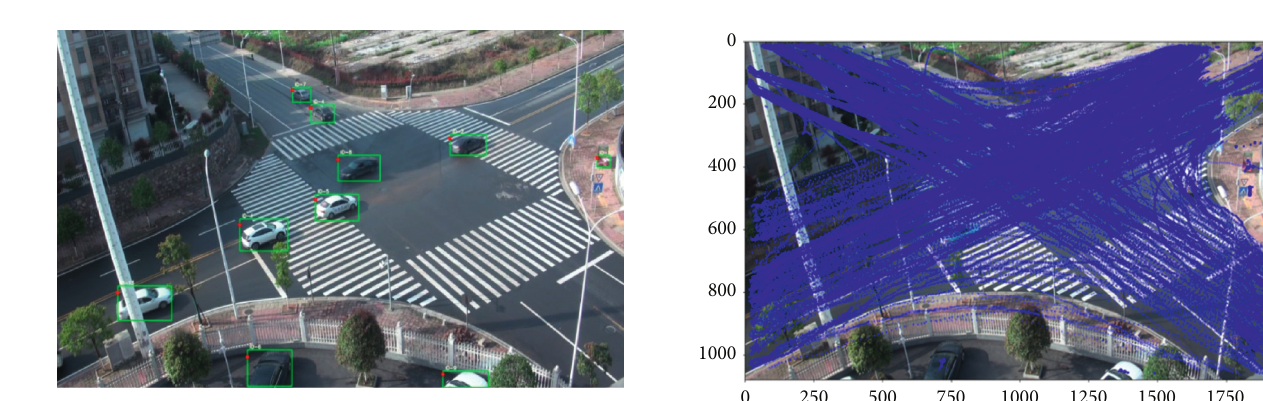
Figure 4: Vehicle detection and tracking results.